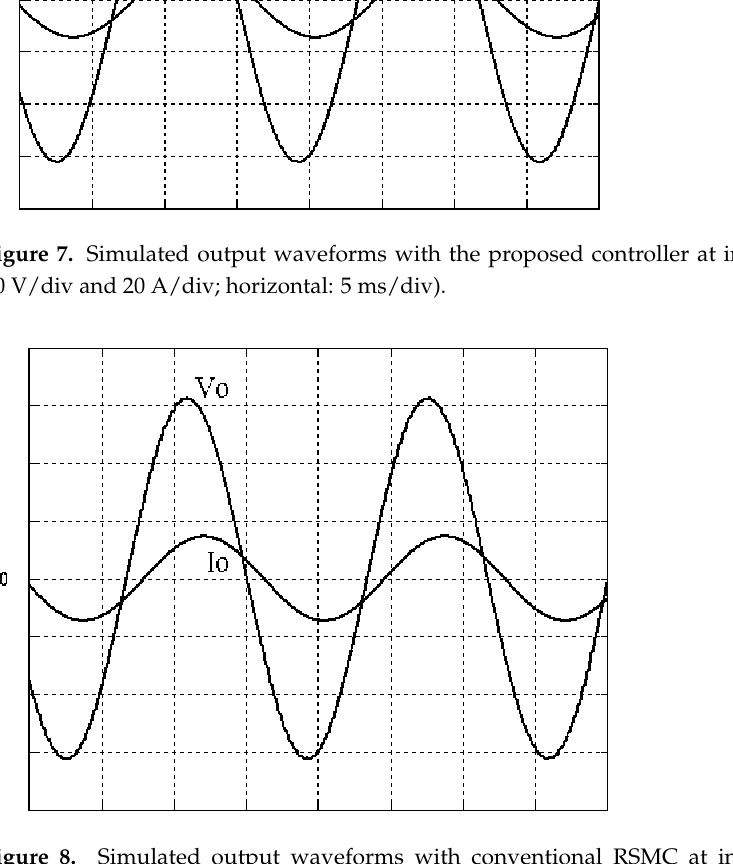
Figure 8. Simulated output waveforms with conventional RSMC at inductive load (vertical: 100 V/div and 20 A/div; horizontal: 5 ms/div).